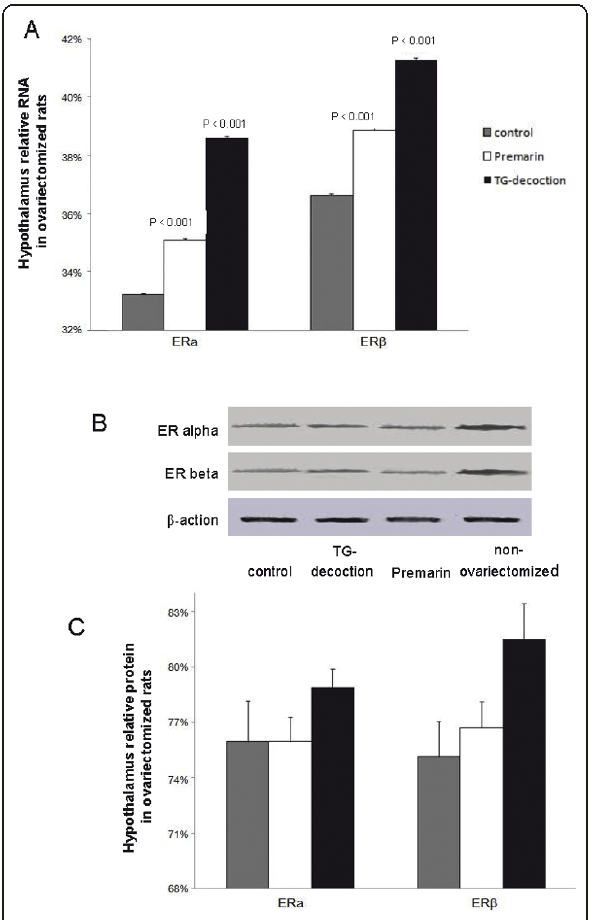
Figure 2 Expression of ER a and b . ER a and b in ovariectomized rats at RNA (A) and protein (B, C) levels. B: Western blotting. Gray bars = untreated, white bars = Premarin-treated, black bars = TG- decoction-treated ovariectomized rats. All values are relative to those of non-ovariectomized